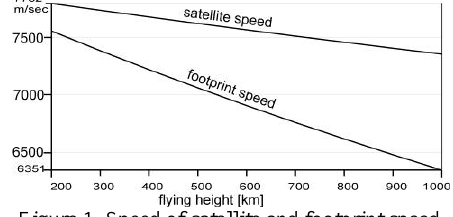
Figure 1. Speed of satellite and footprint